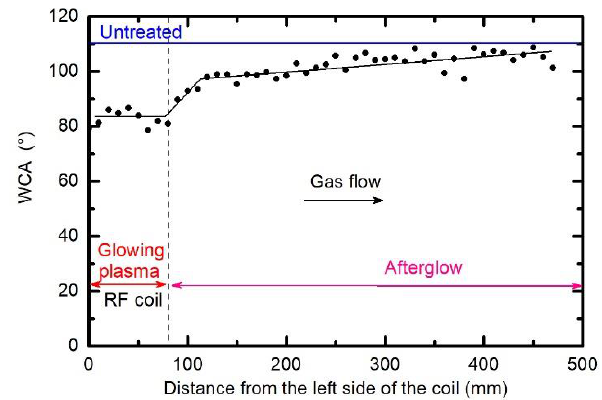
Figure 2. Variation of water contact angle (WCA) on the polytetrafluoroethylene (PTFE) surface of the samples arranged along the discharge tube. The treatment time was 1 s, the hydrogen pressure was 25 Pa, and the discharge power was 400 W.